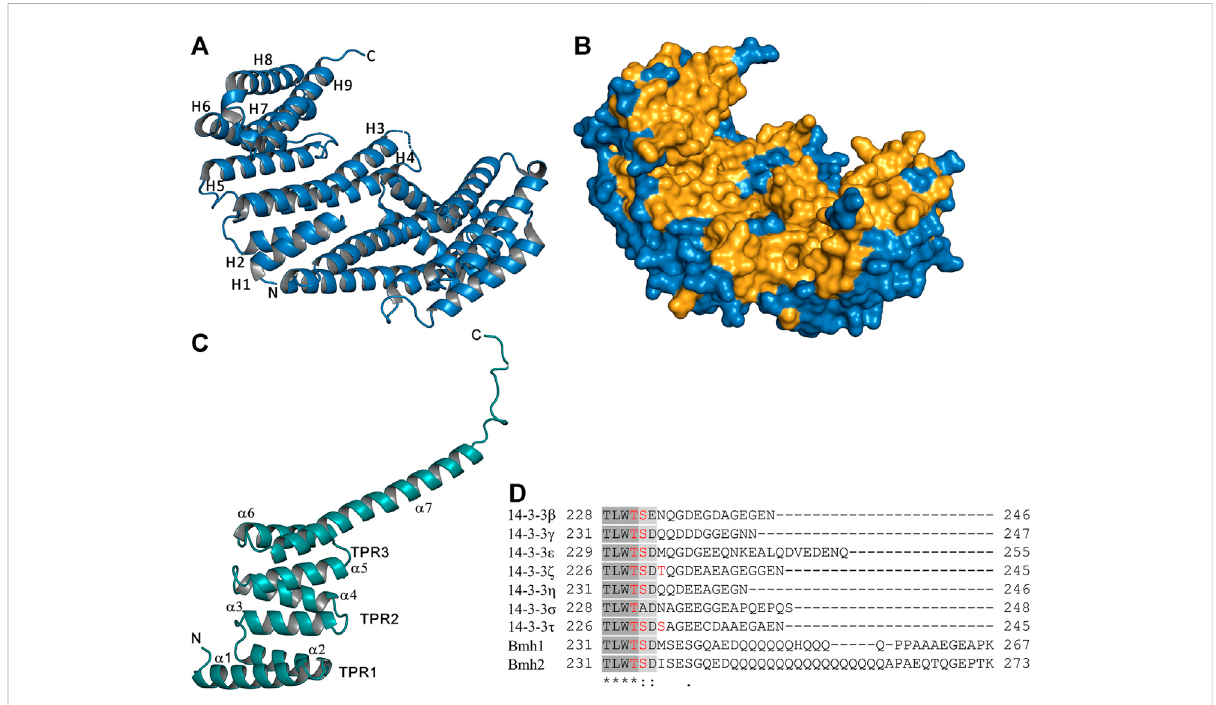
FIGURE 1 Structure of 14-3-3 proteins. (A) Crystal structure of the human 14-3-3 protein isoform ζ , the ribbon representation, and α -helices of one protomer are labeled (PDB ID: 1QJB) (Rittinger et al., 1999). (B) Surface representation of the human 14-3-3 protein isoform ζ ; the totally conserved residuesamongallsevenhumanandtwoyeast14-3-3isoformsareshadedinbrightorange. (C) CrystalstructureoftheTPRdomainofPP5, α -helices andTPRmotifsformedbytwo α -helicesarelabeled(PDBID:1A17)(Dasetal.,1998). (D) SequencealignmentoftheC-terminalpartoftheseven human( β , γ , ε , ζ , η , σ and τ )andtwoyeast(Bmh1andBmh2)14-3-3proteinisoformsusingClustalOmega;phosphorylationsitespresentinthisregion are highlighted in red (Pennington et al., 2018). The fi gure was prepared with PyMOL